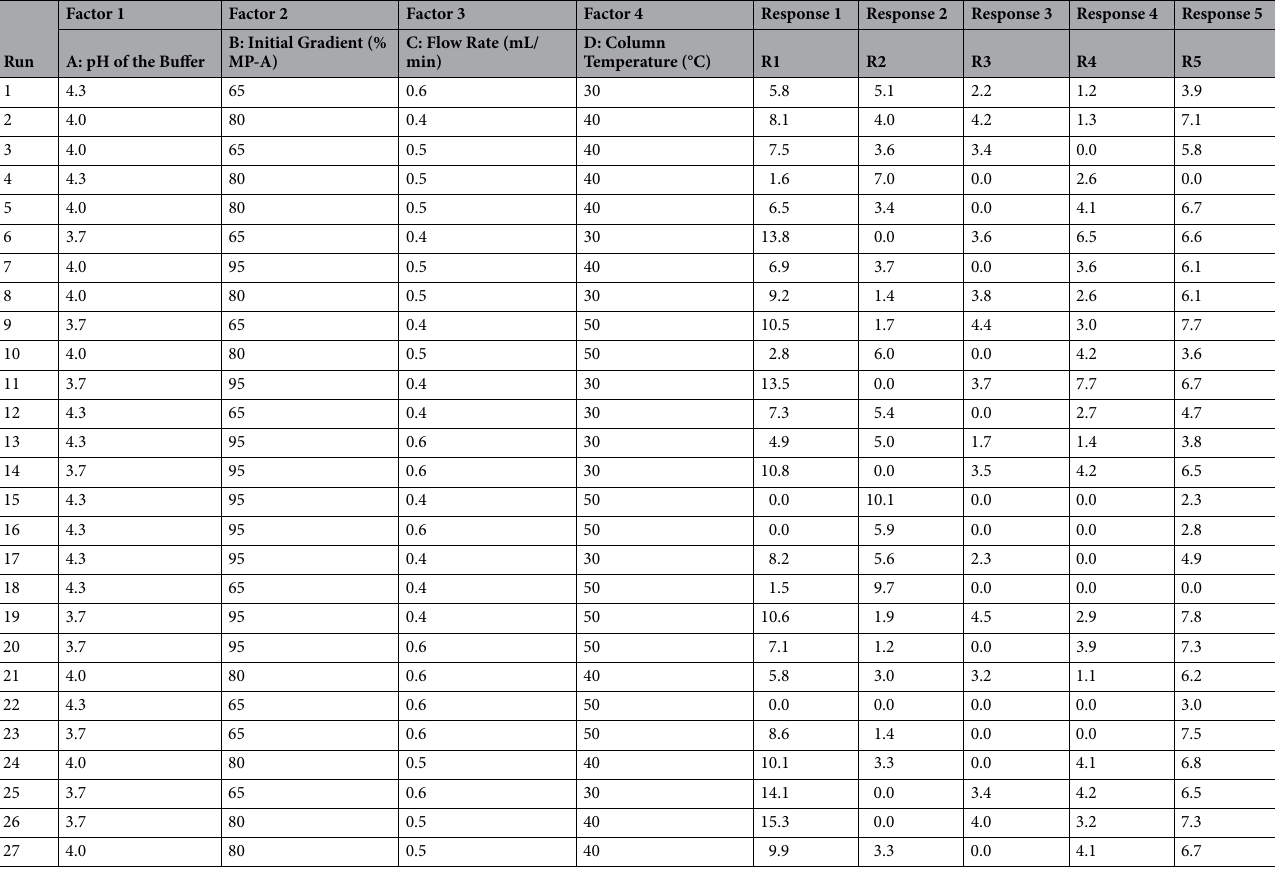
Table 2. The CCD data with input variables and output responses a,b . a R1: Rs between Imp-E & A; R2: